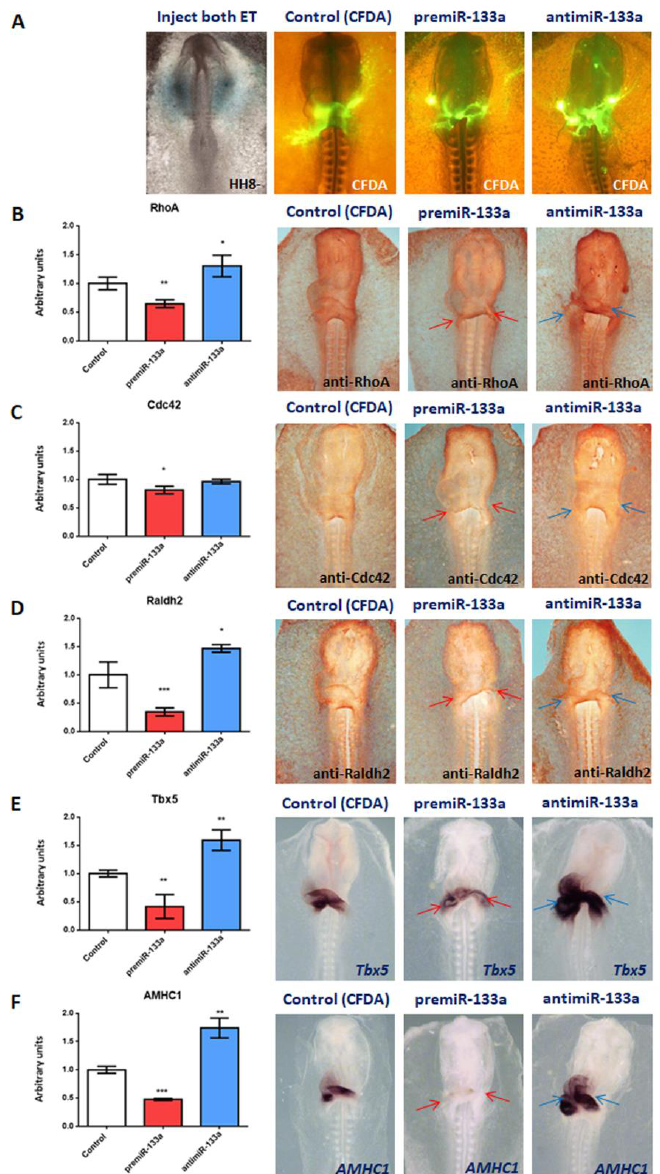
Figure 3. Effect of miR-133a gain- and loss-of-function on posterior cardiac segment. Whole-mount IMH for RhoA, Cdc42 and Raldh2. and ISH for Tbx5 and AMHC1. Embryos microinjected with CFDA (control), premiR-133a or antimiR-133a, at the level of the posterior cardiac precursors of both primitive endocardial tubes, and visualisation of CFDA ( A ). Note that, at the atrium and inflow tract levels, RhoA ( B ), Cdc42 ( C ), Raldh2 ( D ), Tbx5 ( E ) and AMHC1 ( F ) are dramatically reduced, and an atrophic sino-atrial region in the heart tube after premiR-133a treatment is indicated by the red arrows, whereas they are markedly increased and expanded after miR-133a inhibition (blue arrows). RT-qPCR of RNA from dissected cardiac asa (left side) in embryos microinjected either with CFDA, premiR-133a or antimiR-133a. A high level of miR-133a leads to decreased RhoA, Cdc42, Raldh2, Tbx5 and AMHC1 transcripts, whereas miR-133a inhibition leads to increased transcripts. The standard deviations are from three independent experiments. Student’s t -test: * p < 0.05, ** p < 0.01, *** p < 0.005 with respect to control (CFDA) embryos.